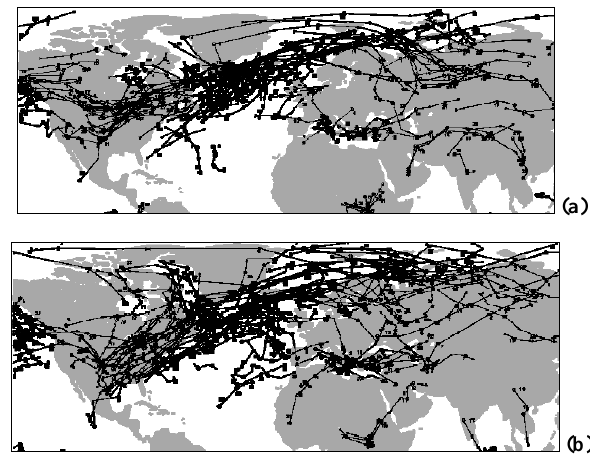
Figure 6. January storm tracks during the periods of the (a) mini- mum (1971–1975) and (b) maximum (1994–1998) AMO index.